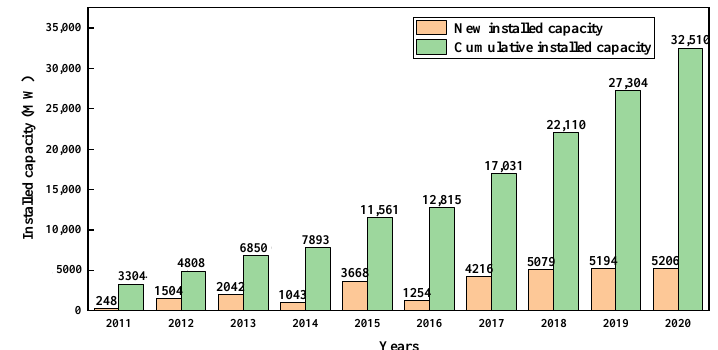
Figure 1. Global installed capacity of offshore wind power [7].